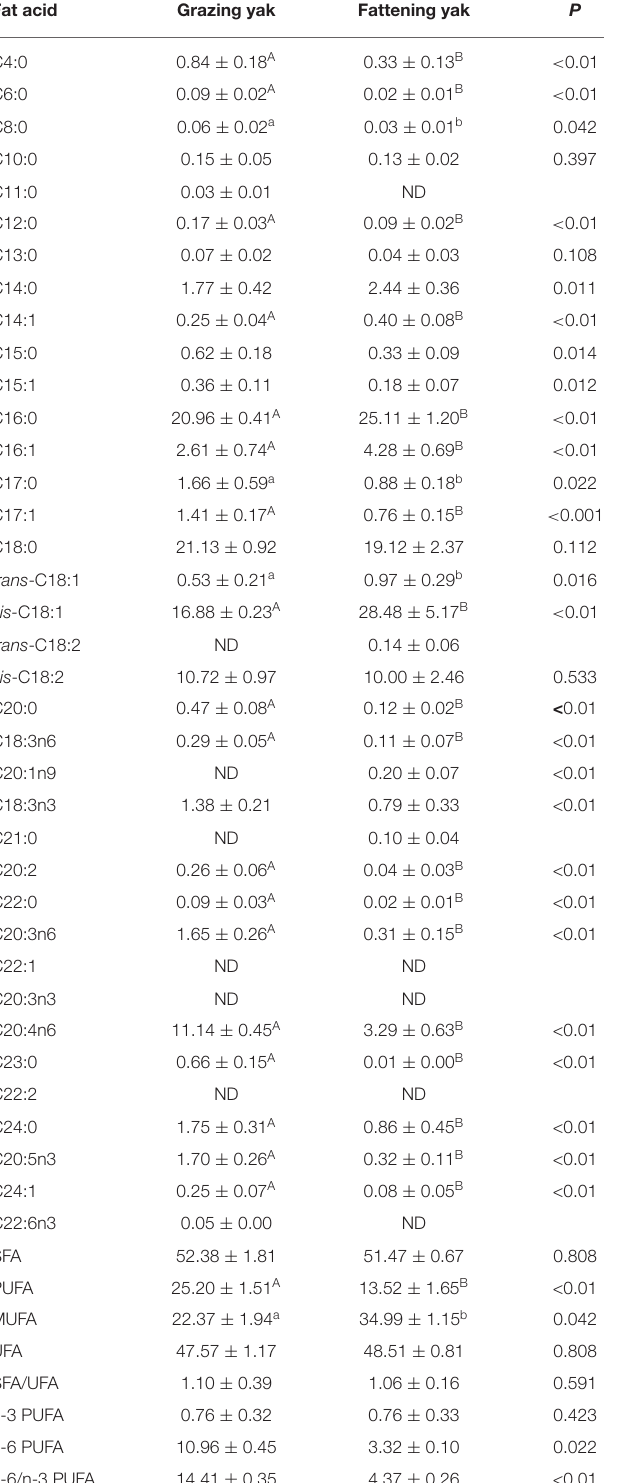
TABLE 5 | Effects of the intensive fattening with TMR on the amino acid composition in longissimus dorsi muscle of yaks (mean ± SD, g/100g). Amino acid Grazing yak Fattening yak